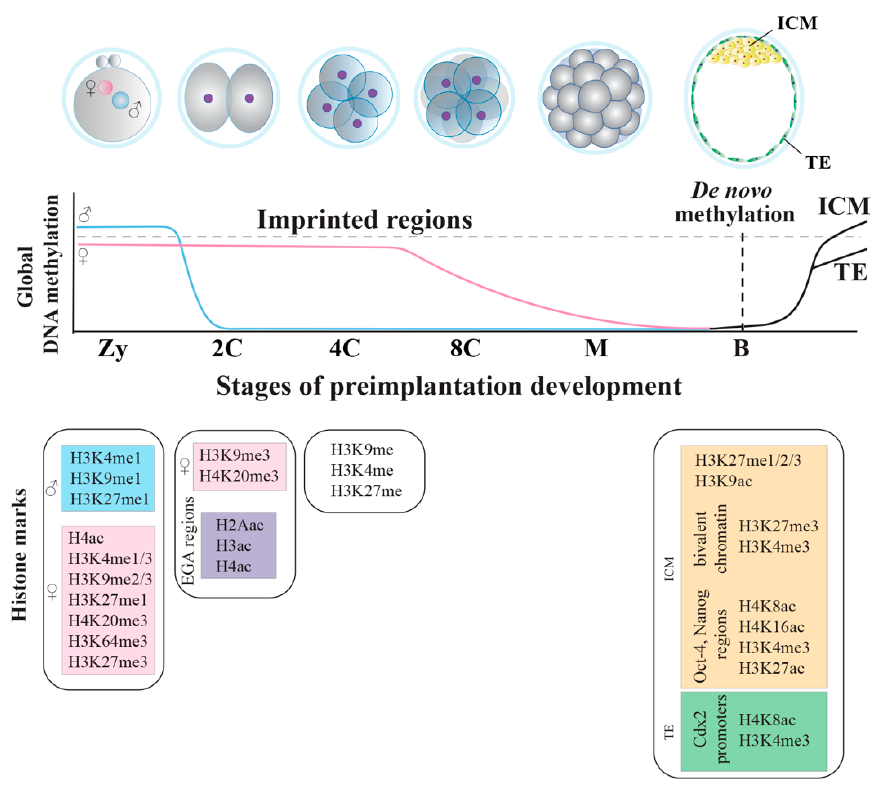
Figure 3. Methylation dynamics during mouse embryonic preimplantation development. After fertilization, the male genome (blue) undergoes fast demethylation, whereas the female genome (pink) undergoes a slow passive DNA demethylation. De novo methylation occurs at the blastocyst stage, with a differential methylation pattern between the ICM and the TE. Specific histone marks are present in the male and female genomes and in the embryo at different pre-implantation stages. Zy, zygote. C, cell. M, morula. B, blastocyst. ICM, inner cell mass. TE, trophectoderm.